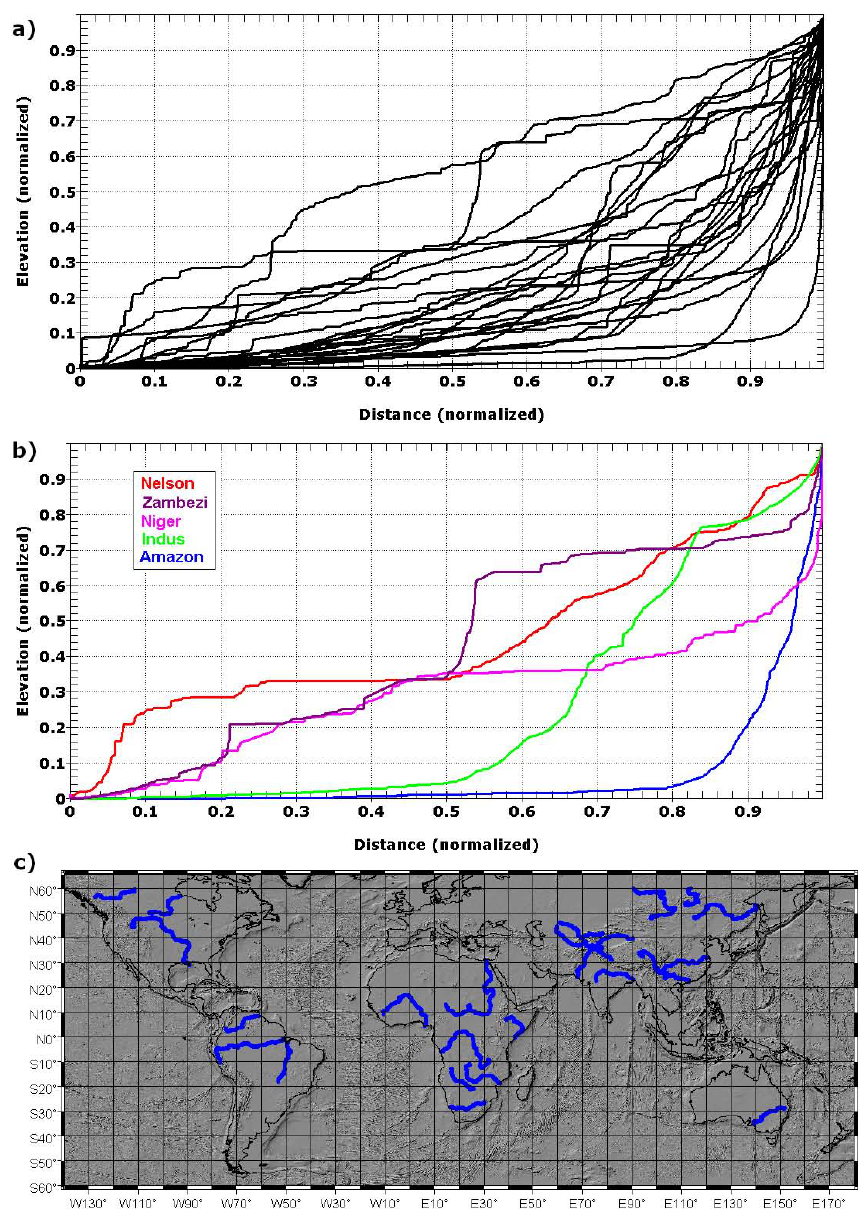
Fig. 7. Thalwegs for the 25 largest global drainage basins (thalweg relief > 500m, Strahler order > =8): (a) normalized basin profiles for all 25 thalwegs; (b) labeled thalwegs for 5 channels; (c) locations for the thalwegs